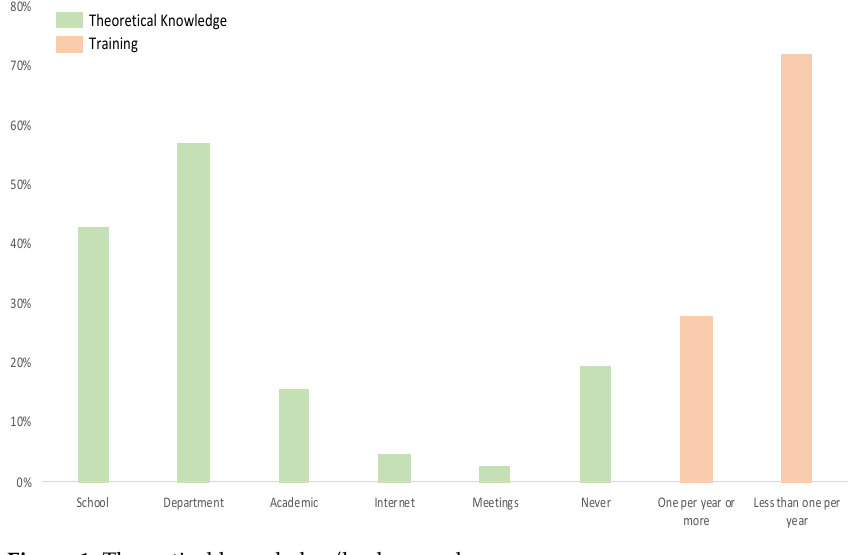
Figure 1. Theoretical knowledge/background.